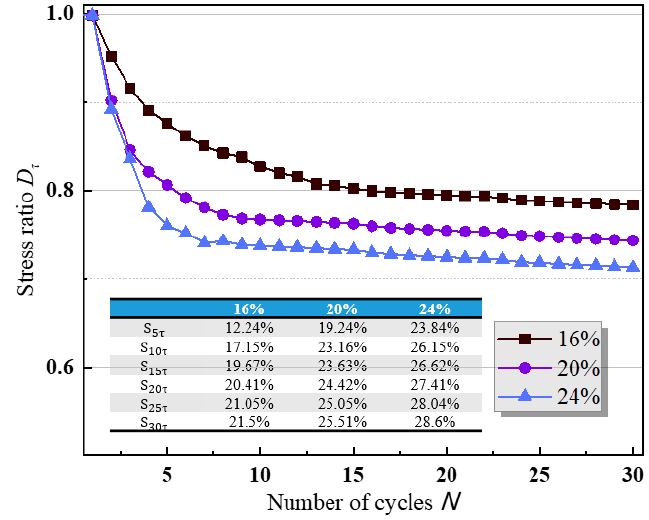
Figure 15. Stress ratio–number of cycles curve under different water content conditions.